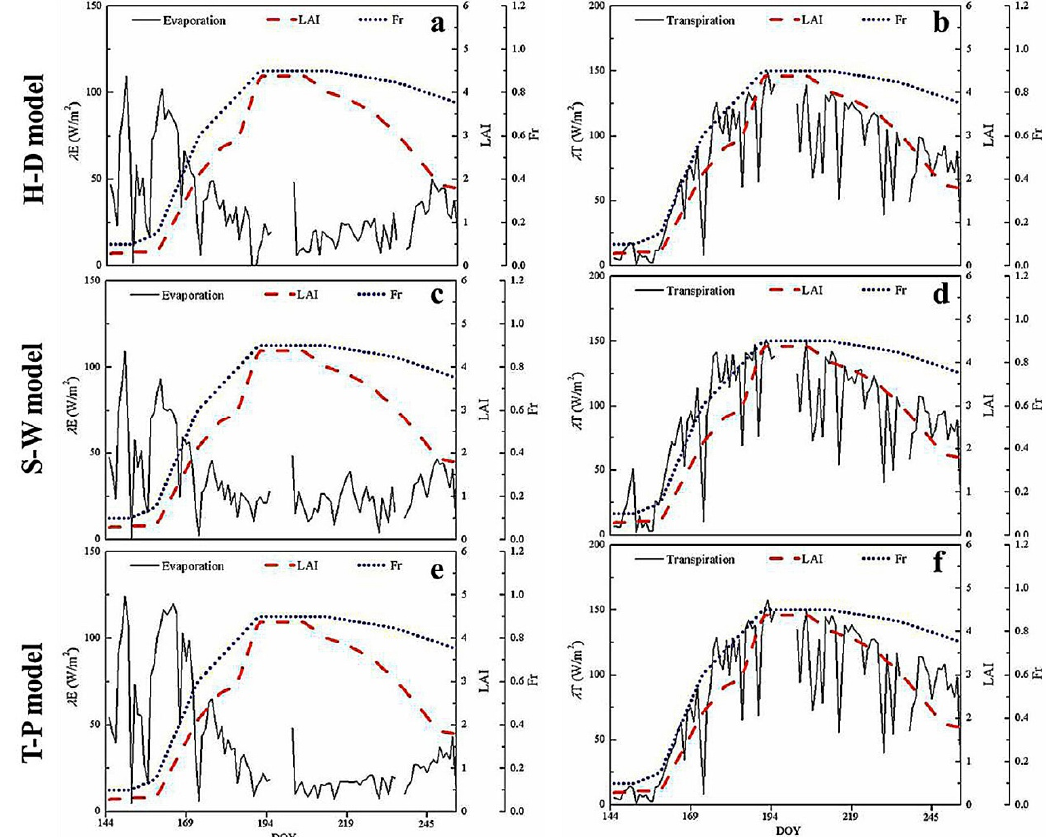
Figure 8. Variations in daily leaf area index (LAI), fractional vegetation coverage ( F r), and estimated evaporation evaporation ( λ E) ( left ) and transpiration ( λ T) ( right ) from three-dual source ET models: H-D model ( a , b ), S-W model ( c , d ) and T-P model ( e , f ), at the US_Bo1